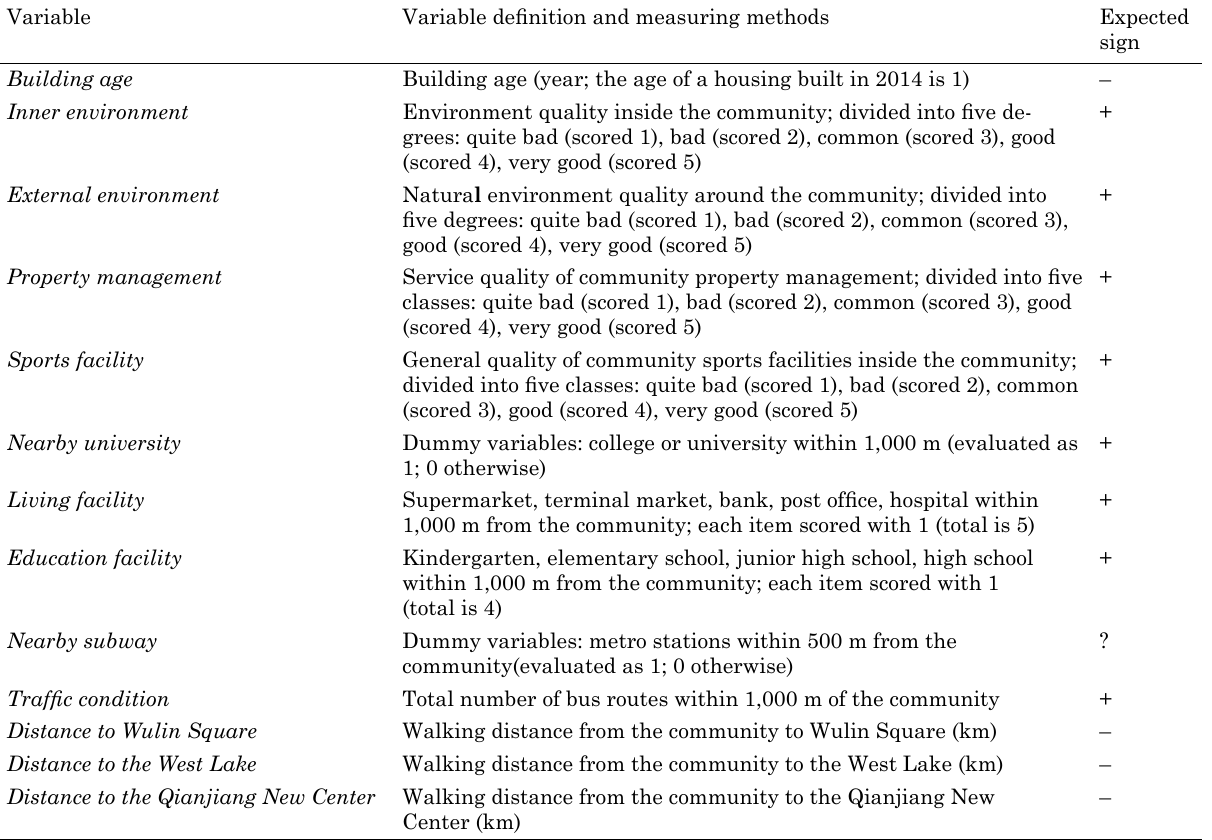
Table 1. Variable definitions and expected signs